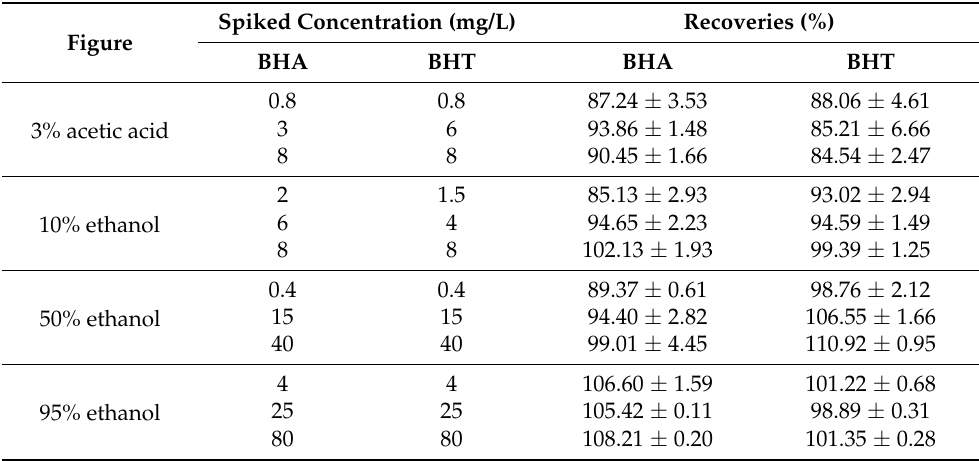
Table 8. The recoveries and RSDs of the BHA and BHT in the migration experiment (mean ± SD, n = 3).